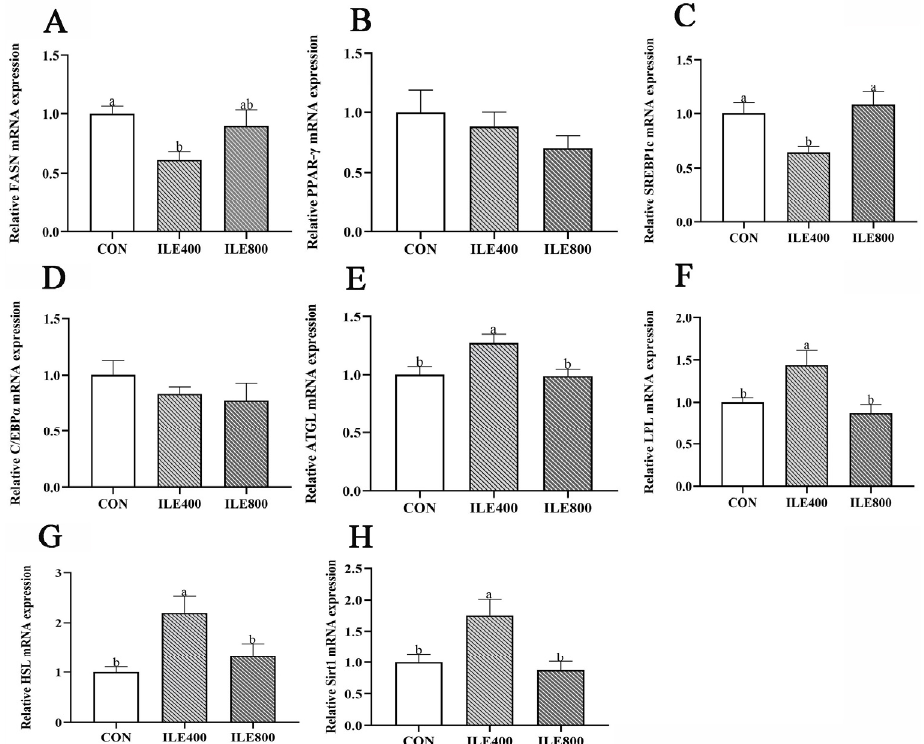
Figure 1. The effect of dietary supplementation with isoleucine (Ile) on the expressions of genes related to liver fat metabolism in broiler chickens. ( A ) FASN , fatty-acid synthase; ( B ) PPAR- γ , peroxi- some proliferator activated receptor-gamma; ( C ) SREBP1c , solid alcohol regulatory element binding protein1c; ( D ) C/EBP α , CCAAT/enhancer binding proteins alpha; ( E ) ATGL , adipose triglyceride lipase; ( F ) LPL , lipoprotein lipase; ( G ) HSL , hormone-sensitive lipase; ( H ) Sirt1 , sirtuin1. CON, broiler chickens were fed the basal diet; ILE400, basal diet supplemented with 400 mg/kg Ile; ILE800, basal diet supplemented with 800 mg/kg Ile. The values are presented as the mean and standard error of mean (SEM), and statistically significant differences are those with a,b p <